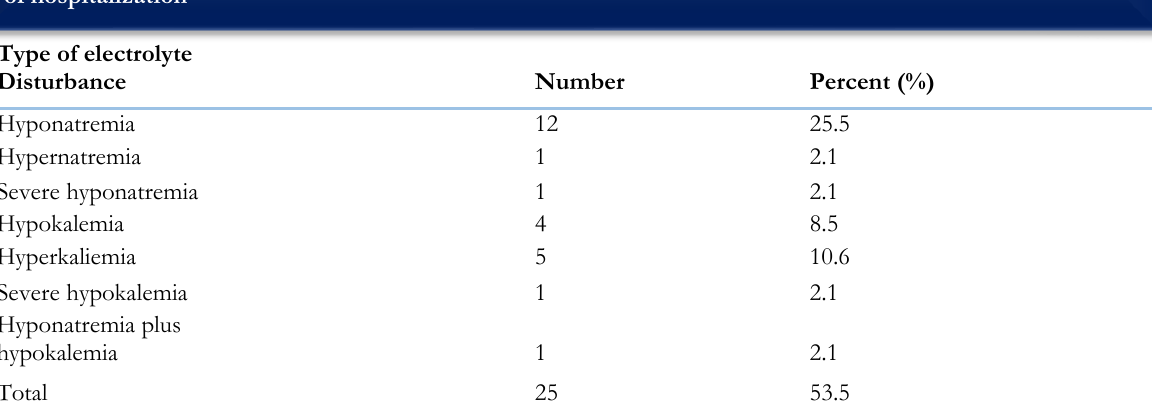
Table 3: Frequency of abnormal serum sodium and potassium concentrations among 47 patients at point of